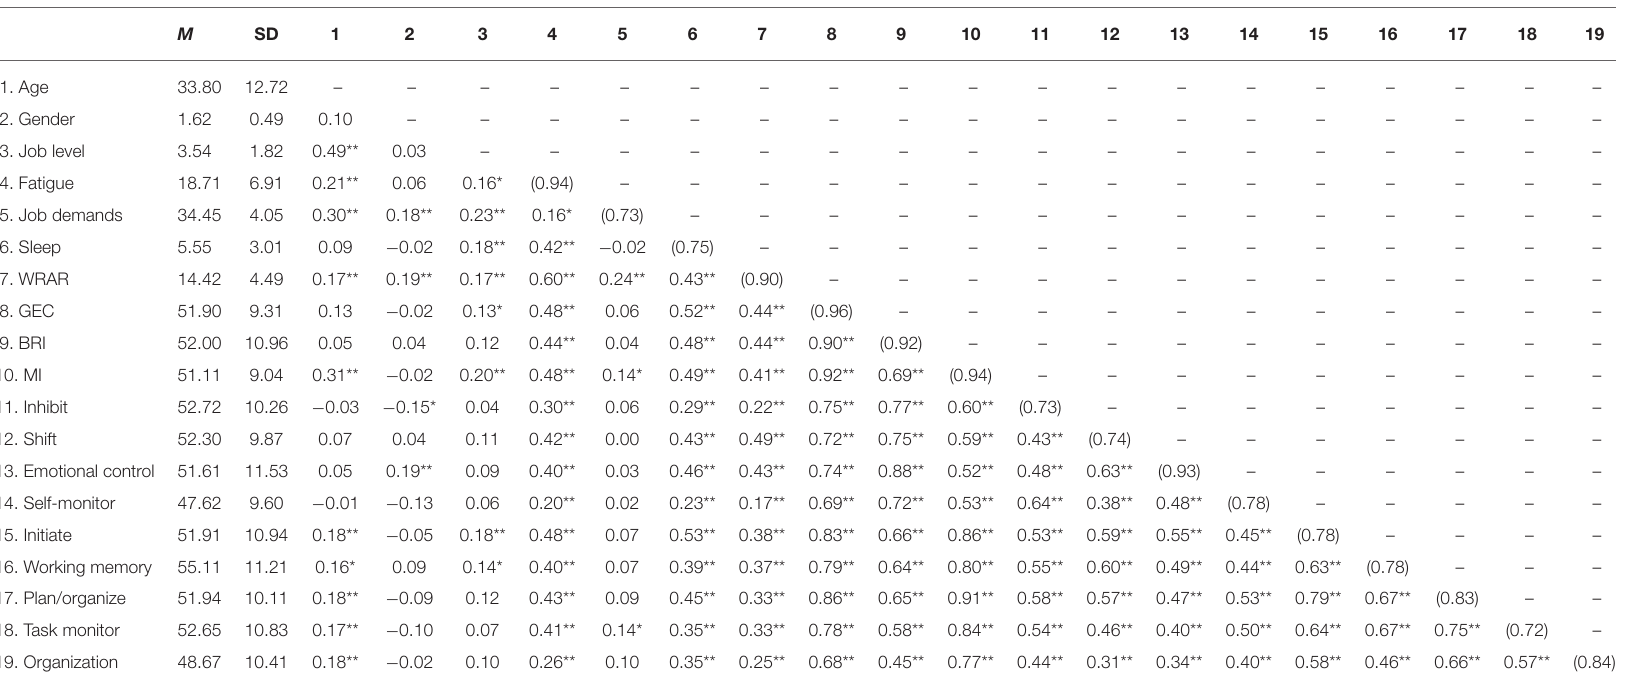
TABLE 3 | Correlations for study two variables.